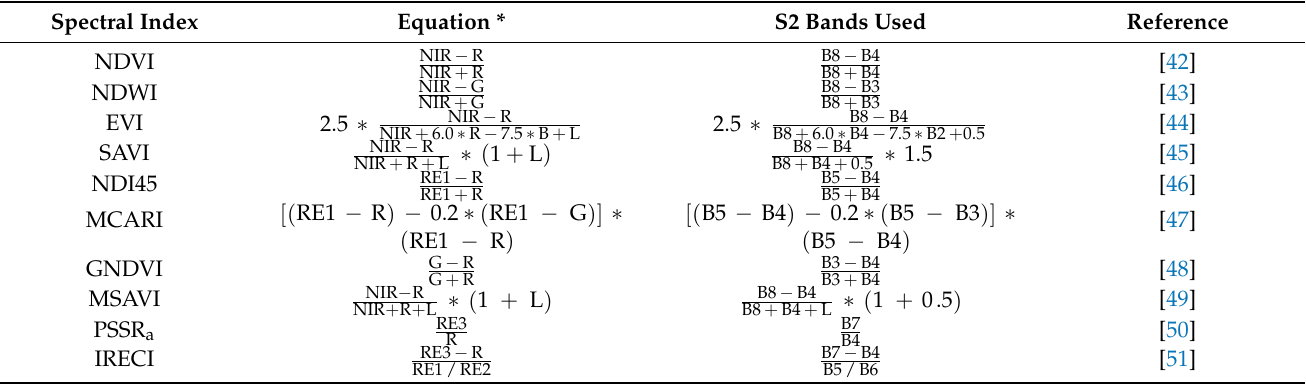
Table 2. Sentinel-1 (S1) and Sentinel-2 (S2) imagery used in this